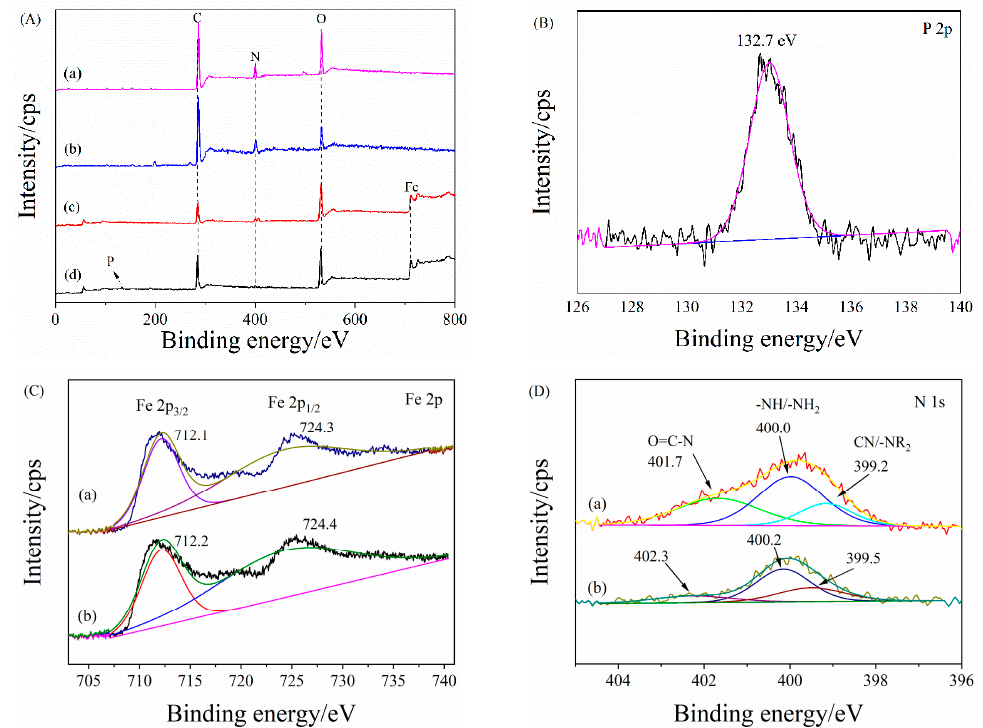
Figure 7. ( A ) XPS survey of (a) PANF, (b) PAN A F, (c) PAN A F-FeOOH, and (d) PAN A F-FeOOH-P; ( B ) High-resolution spectrum of P 2p for PAN A F-FeOOH-P; ( C ) High-resolution Fe 2p spectrum of (a)